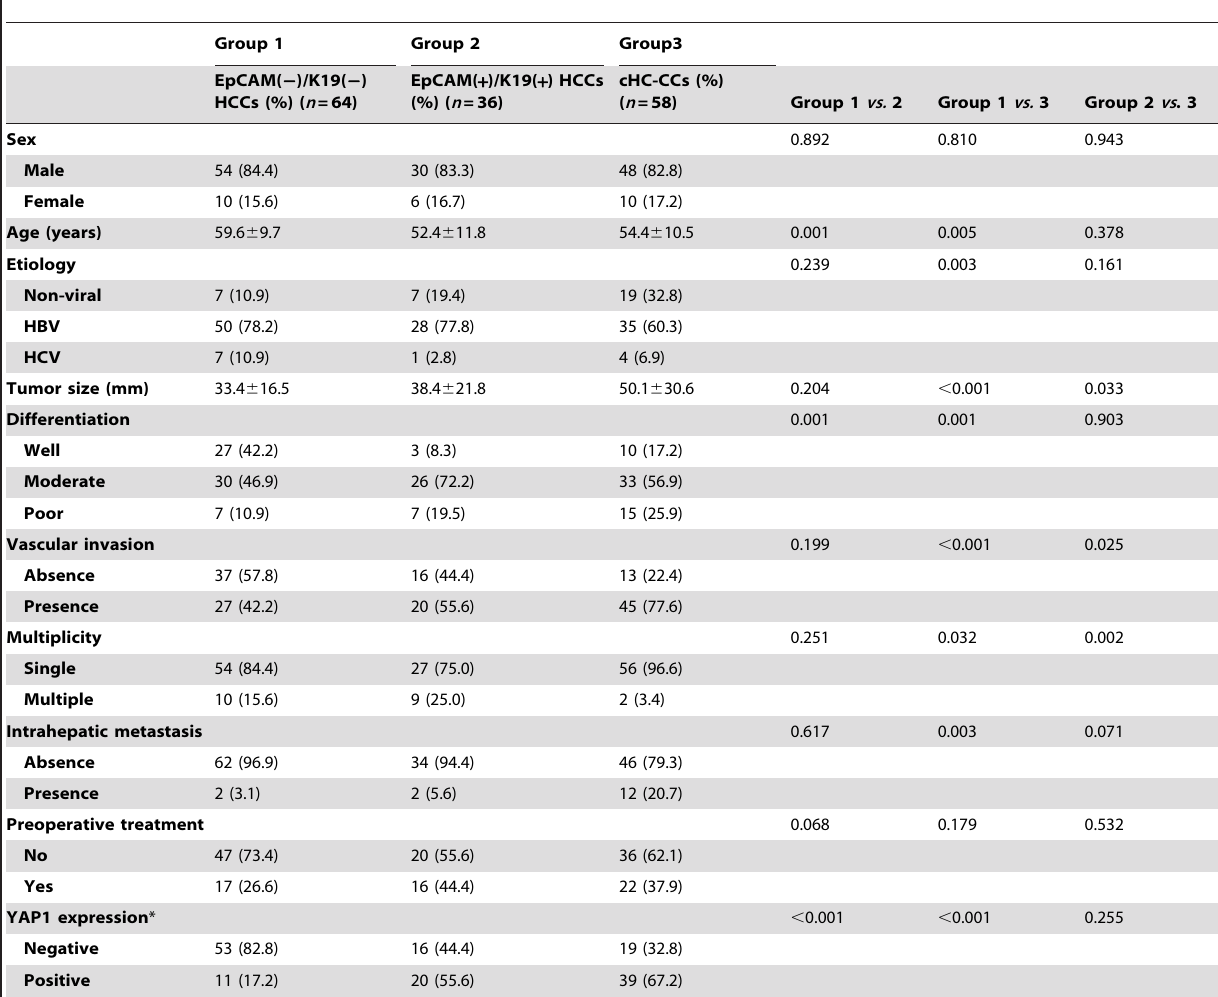
Table 1. Clinicopathological features and YAP1 expression in HCCs and combined hepatocellular-cholangiocarcinomas (cHC-CCs).